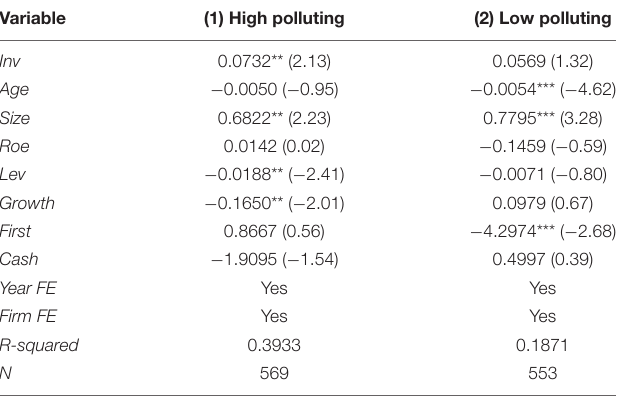
TABLE 4 | Heterogeneity results for high versus low polluting industry. Variable